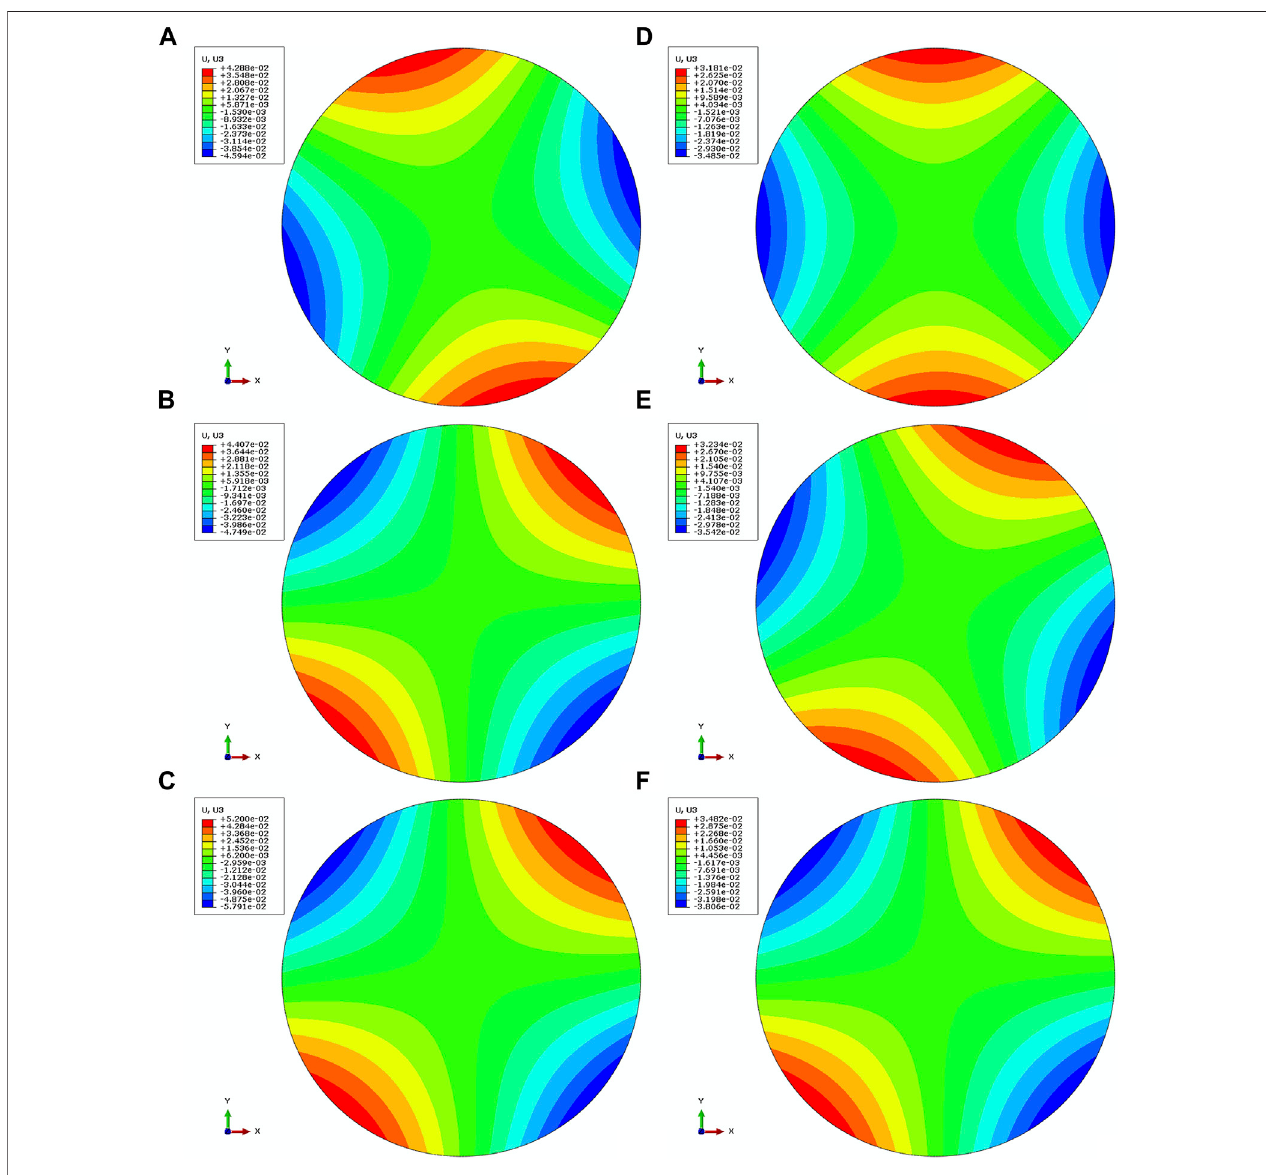
FIGURE 4 | Out-of-plane deformation for six stacking sequences with unit ply angle misalignment in the fi rst layer. (A) Stacking No. 1; (B) Stacking No. 2; (C) Stacking No. 3; (D) Stacking No. 4; (E) Stacking No. 5; (F) Stacking No. 6.